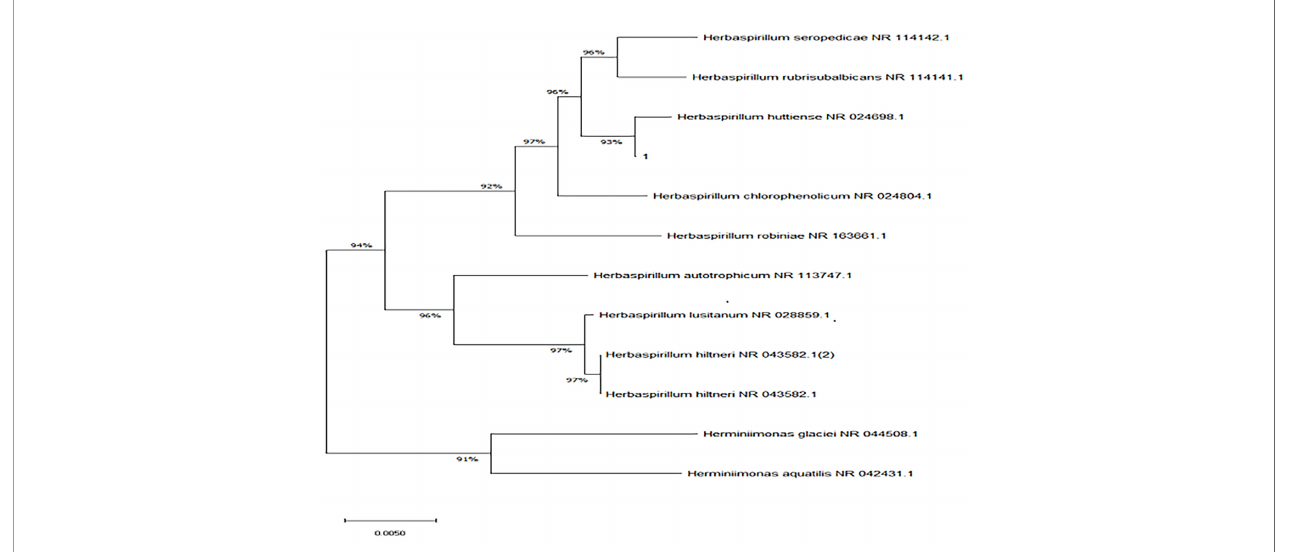
FIGURE 4 | Neighbor-joining phylogenetic tree of H. huttiense indicated high homology (1:isolated strain).